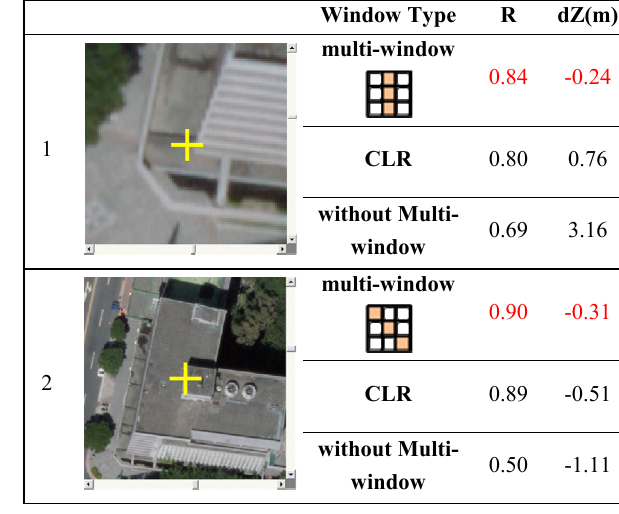
Table 4. Results of Object-based Matching in P1 and